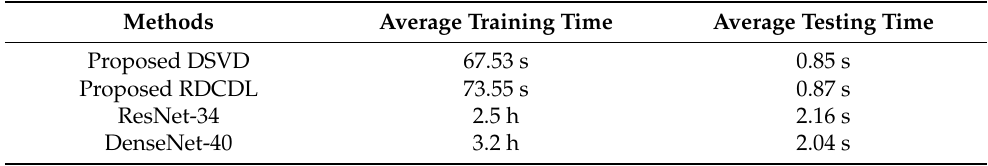
Table 7. Average training time and testing time on CASIA-WebFace